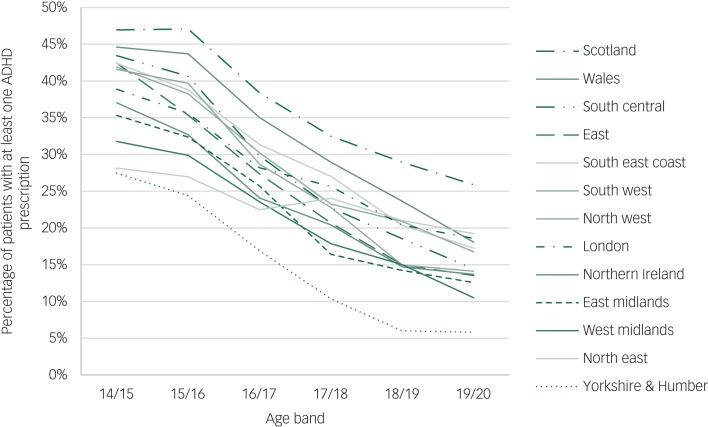
Percentage of patients with attention-deficit hyperactivity disorder (ADHD) with an ADHD prescription, by age band and region.